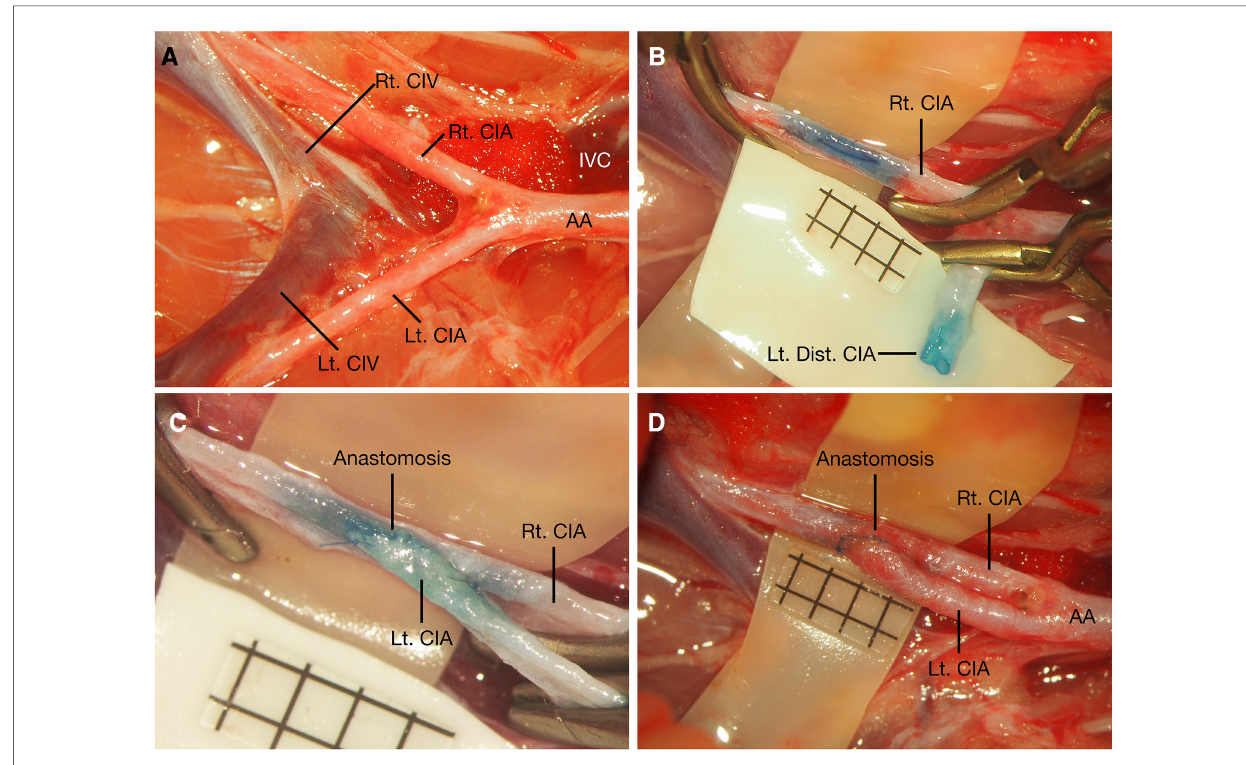
FIGURE 4 Distal CIA to contralateral CIA end-to-side anastomosis. After bilateral CIAs were carefully dissected ( A ), the right CIA was temporarily occluded, the proximal part of the left CIA was temporarily occluded, and the distal part was ligated before its distal bifurcation; the cutting end of the left CIA was cut in fi sh-mouth fashion, and an arteriotomy was made on the right CIA ( B ). Distal CIA to contralateral CIA end-to-side anastomosis was performed ( C ), and blood fl ow was restored by releasing these temporary clips ( D ). Scale bar=1 mm. AA, abdominal aorta; CIA, common iliac artery; CIV, common iliac vein; Dist., distal; IVC, inferior vena cava; Lt., left; Rt.,